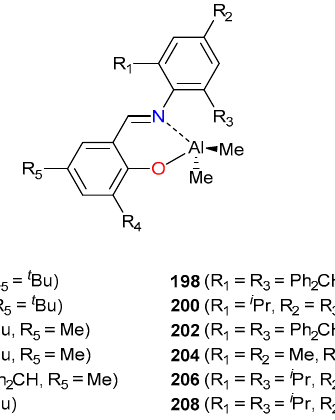
Figure 35. Al-aldiminophenolates complexes active in the ROP of lactides [111].